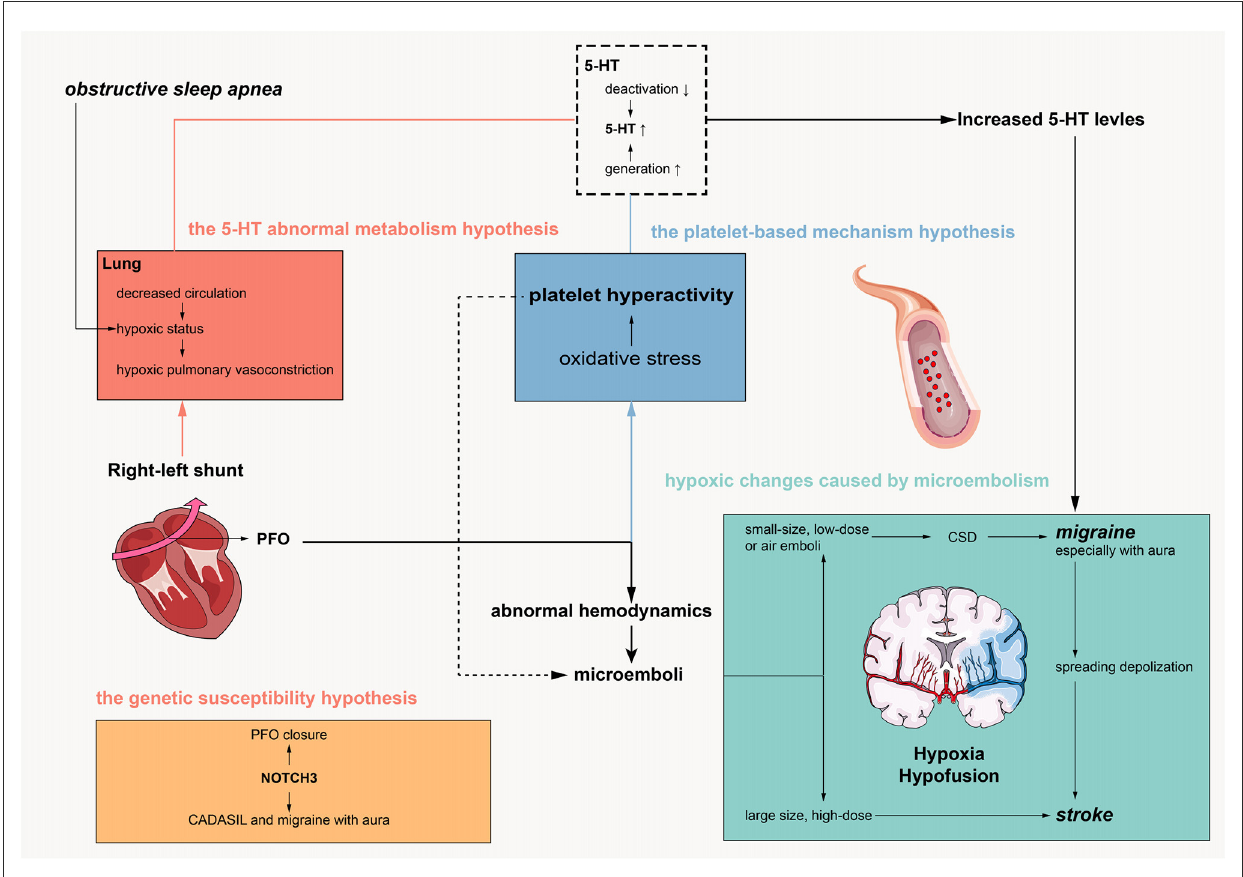
FIGURE1 Pathogenesis of PFO related neurological